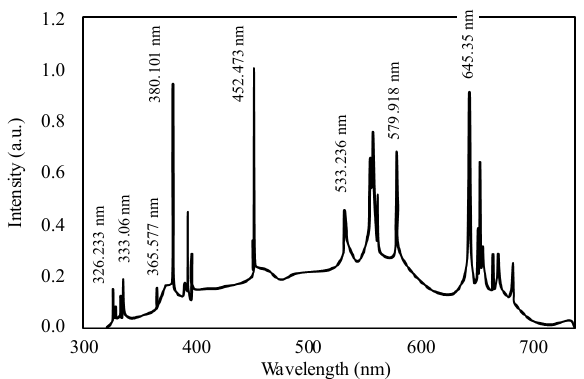
Fig. 2 Optical emission spectrum of tin plasma produced by pulsed laser of 55 MW peak